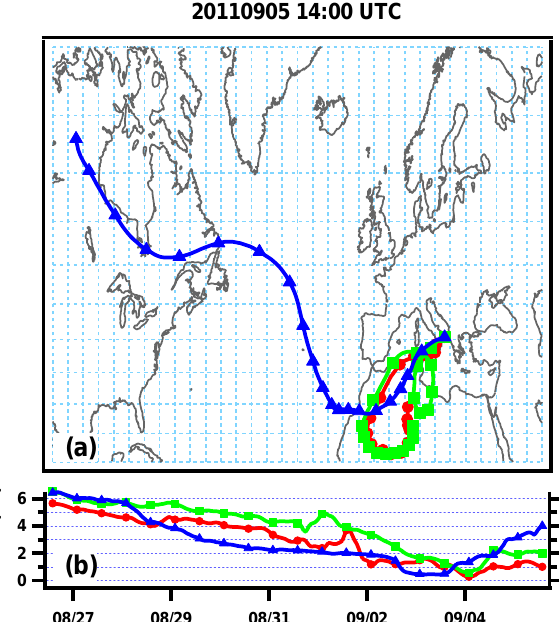
Fig. 10. (a) Pathways estimated for 14:00UTC of 5 September 2011 of the ten day HYSPLIT back trajectories with arrival heights at 1, 2, and 4kma.g.l. (b) Time evolution of the altitude of each back